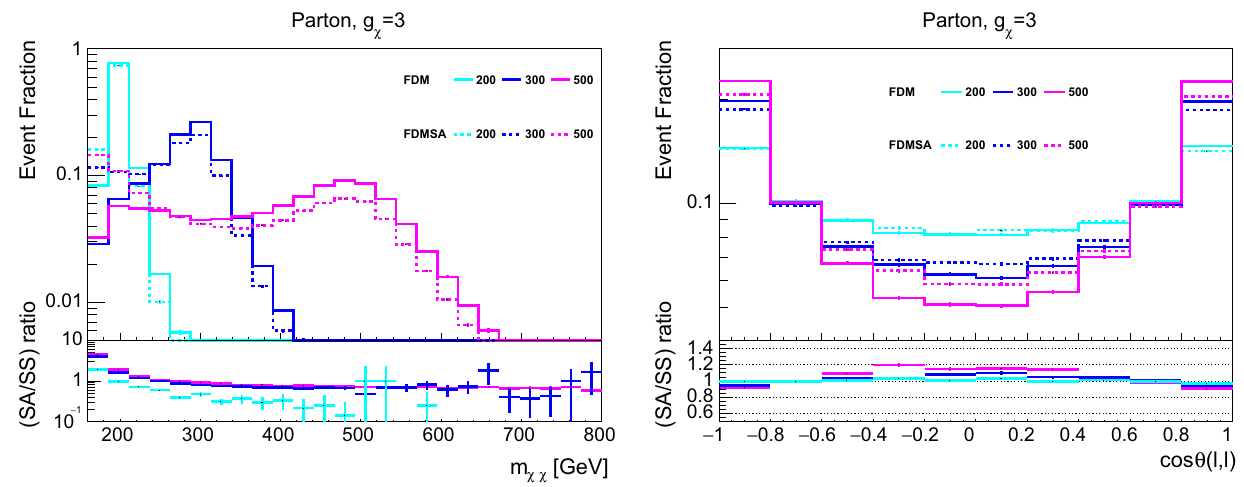
Fig. 12 Parton level distributions of DM pair invariant mass (left) and polar angle difference between two leptons (right) at 100 TeV pp collider